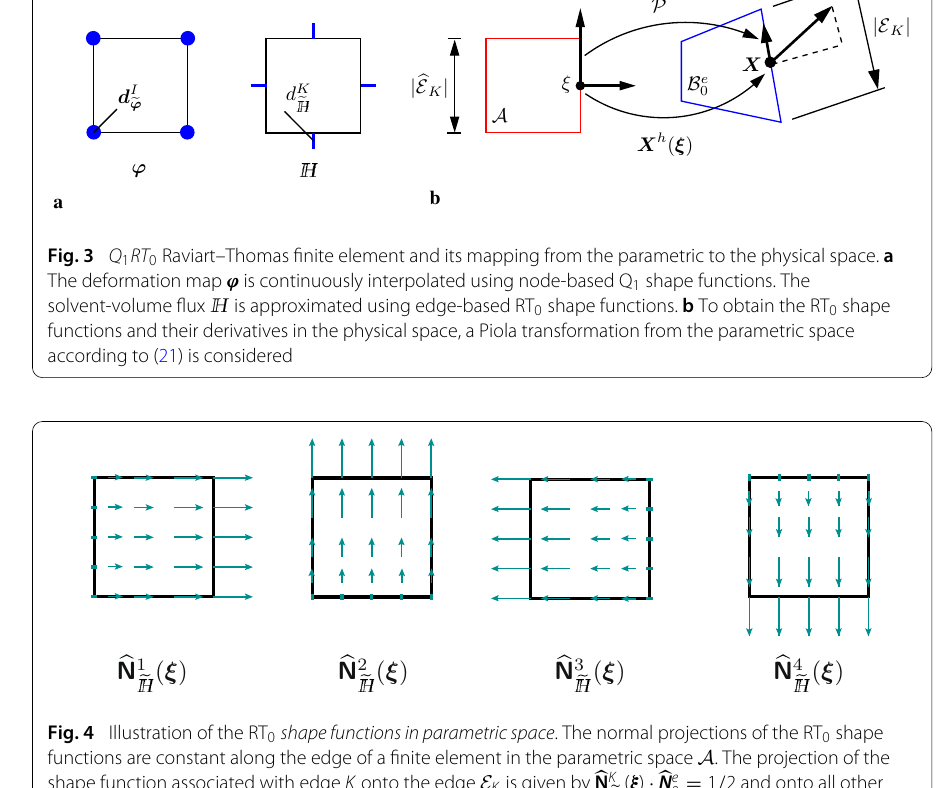
= 1 / 2 and onto all other ( ξ ) · (cid:14) N e 0 H